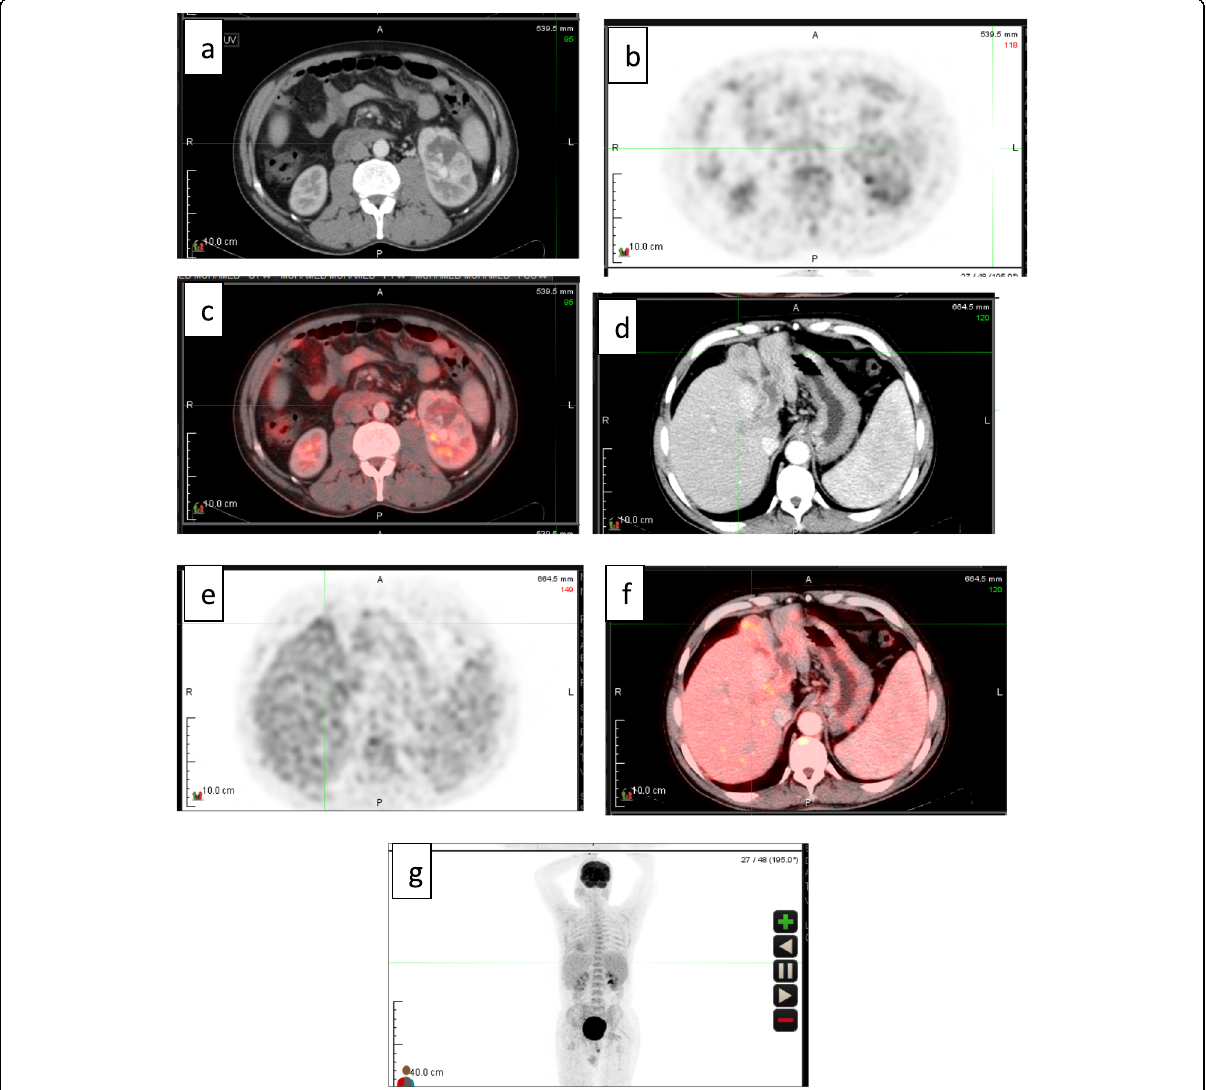
Fig. 6 A 53-year-old male patient with sever epigastric pain referred to the back. US revealed cirrhotic liver changes with diffuse infiltrative mass seen at the left lobe. CT ( a ), PET ( b ), and PET/CT ( c ) revealed left renal solid mass measuring (5.8 × 5.8 cm) with central area of breakdown, the mass is invading the cortex and medulla, displacing and distorting the renal calyces and avid contrast enhancement, mild abnormal increased tracer fixation, patent renal vein. CT ( d ), PET ( e ), PET/CT ( f ), and MIP PET ( g ) revealed ill-defined infiltrative mass seen at the left lobe segment IV with mild increased tracer utilization. Dilated partially thrombosed portal vein trunk and left branch with enhancement thrombus during arterial phase. Biopsy revealed renal cell carcinoma papillary type grade II and infiltrative